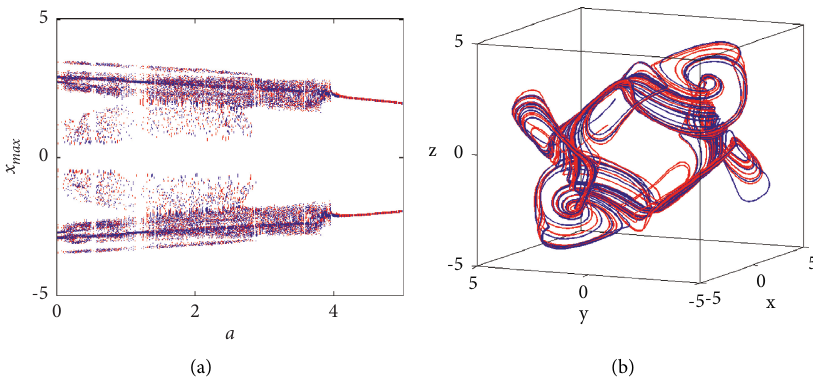
Figure 15: (a) Bifurcation diagram of system (4) for continuous varying a ∈ ( 0 , 5 ) . (b) Coexisting chaotic attractors for a � 1, b � − 9, and [ q , q , q ] � [ 0 . 80 , 0 . 90 , 0 . 91 ] subject to the ICs: ( x 1 2 3